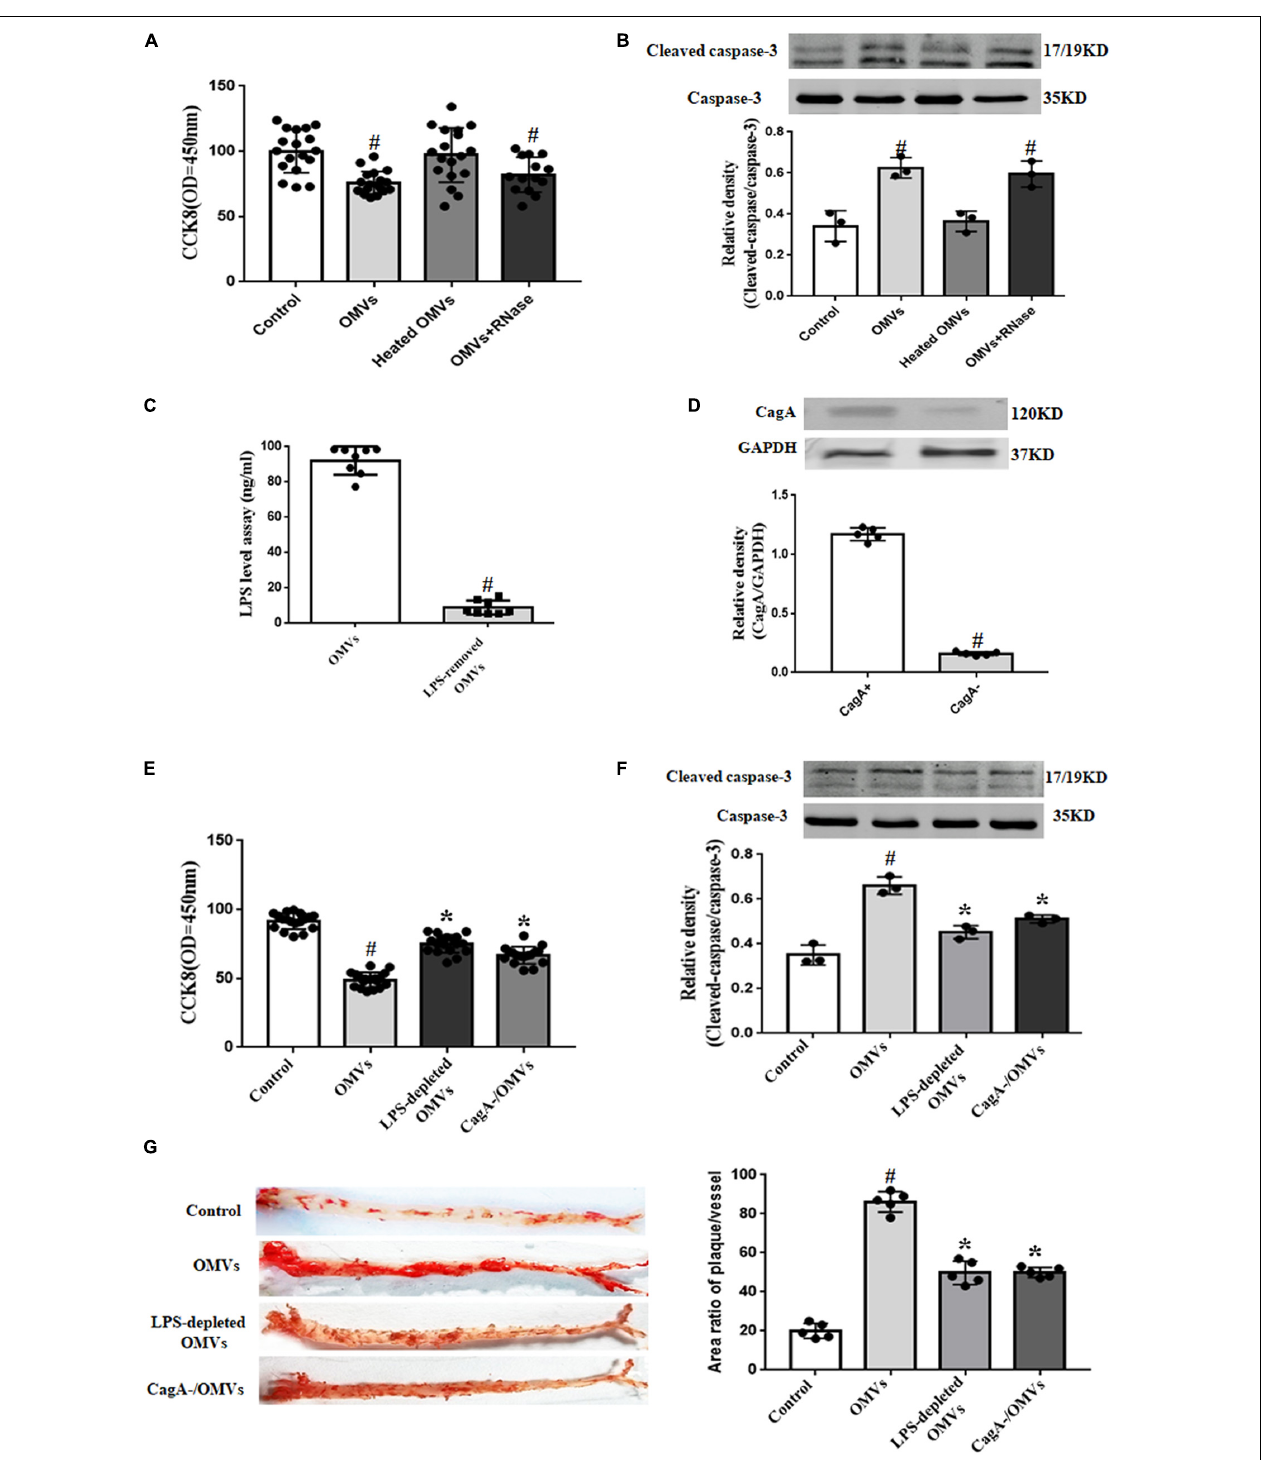
FIGURE 4 | Role of LPS and CagA in H. pylori -derived OMVs-mediated proliferation inhibition and apoptosis in HUVECs. (A,B) HUVECs were administrated with control (vehicle), OMVs (10 µ g/mL), heated OMVs or RNase-treated OMVs for 24 h. Proliferation of HUVECs were determined by CCK8 (A) ( n = 18, # P < 0.01 vs. control); apoptosis of HUVECs were determined by the ratio of cleaved-caspase-3 to caspase-3 expression (B) ( n = 3, # P < 0.01 vs. control). (C) LPS levels were determined by ELISA after treatment with polymyxin B for 1 h at 37 ◦ C ( n = 8, # P < 0.01 vs. OMVs). (D) CagA levels in CagA-positive or -negative OMVs were determined by immunoblotting ( n = 5, # P < 0.01 vs. CagA + ). (E,F) HUVECs were administrated with control (vehicle), OMVs (10 µ g/mL), LPS-depleted OMVs or